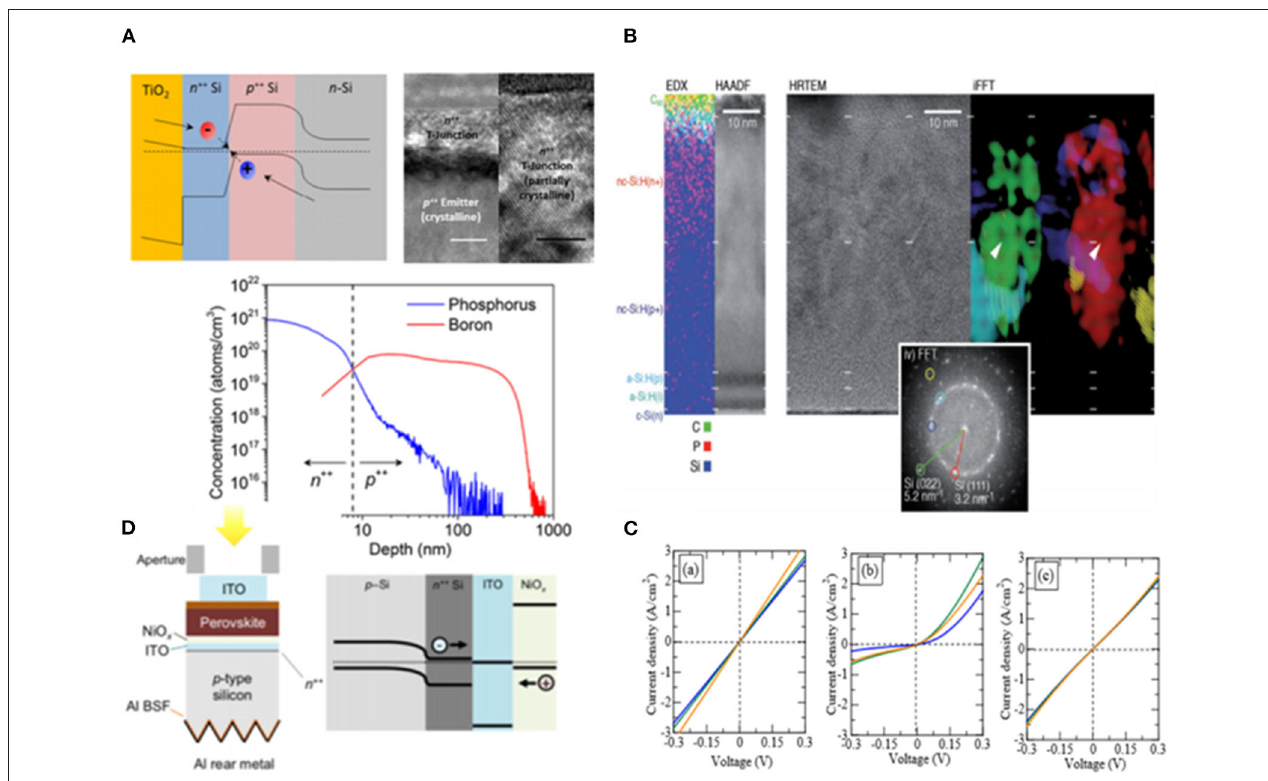
FIGURE 7 | (A) Band diagram, TEM image, and SIMS profile of the PVSK/Si cell tunnel junction interface (reproduced from ref. 67, copyright 2015, AIP). (B) EDX map and corresponding STEM HAADF image of the recombination junction (reproduced from ref. 68, copyright 2017, Wiley ACH). (C) TRJ structure using p-Cu 2 O:N = n-a-Si:H, and TRJ structure using p-Cu 2 O:N = n- µ c-Si:H (reproduced from ref. 69, copyright 2018, The Japan Society of Applied Physics). (D) Device structure of tandems with Al-BSF p-type Si bottom cells and structure of the ITO/NiOx recombination contact on a p-type Si cell (reproduced from ref. 70, copyright 2018,